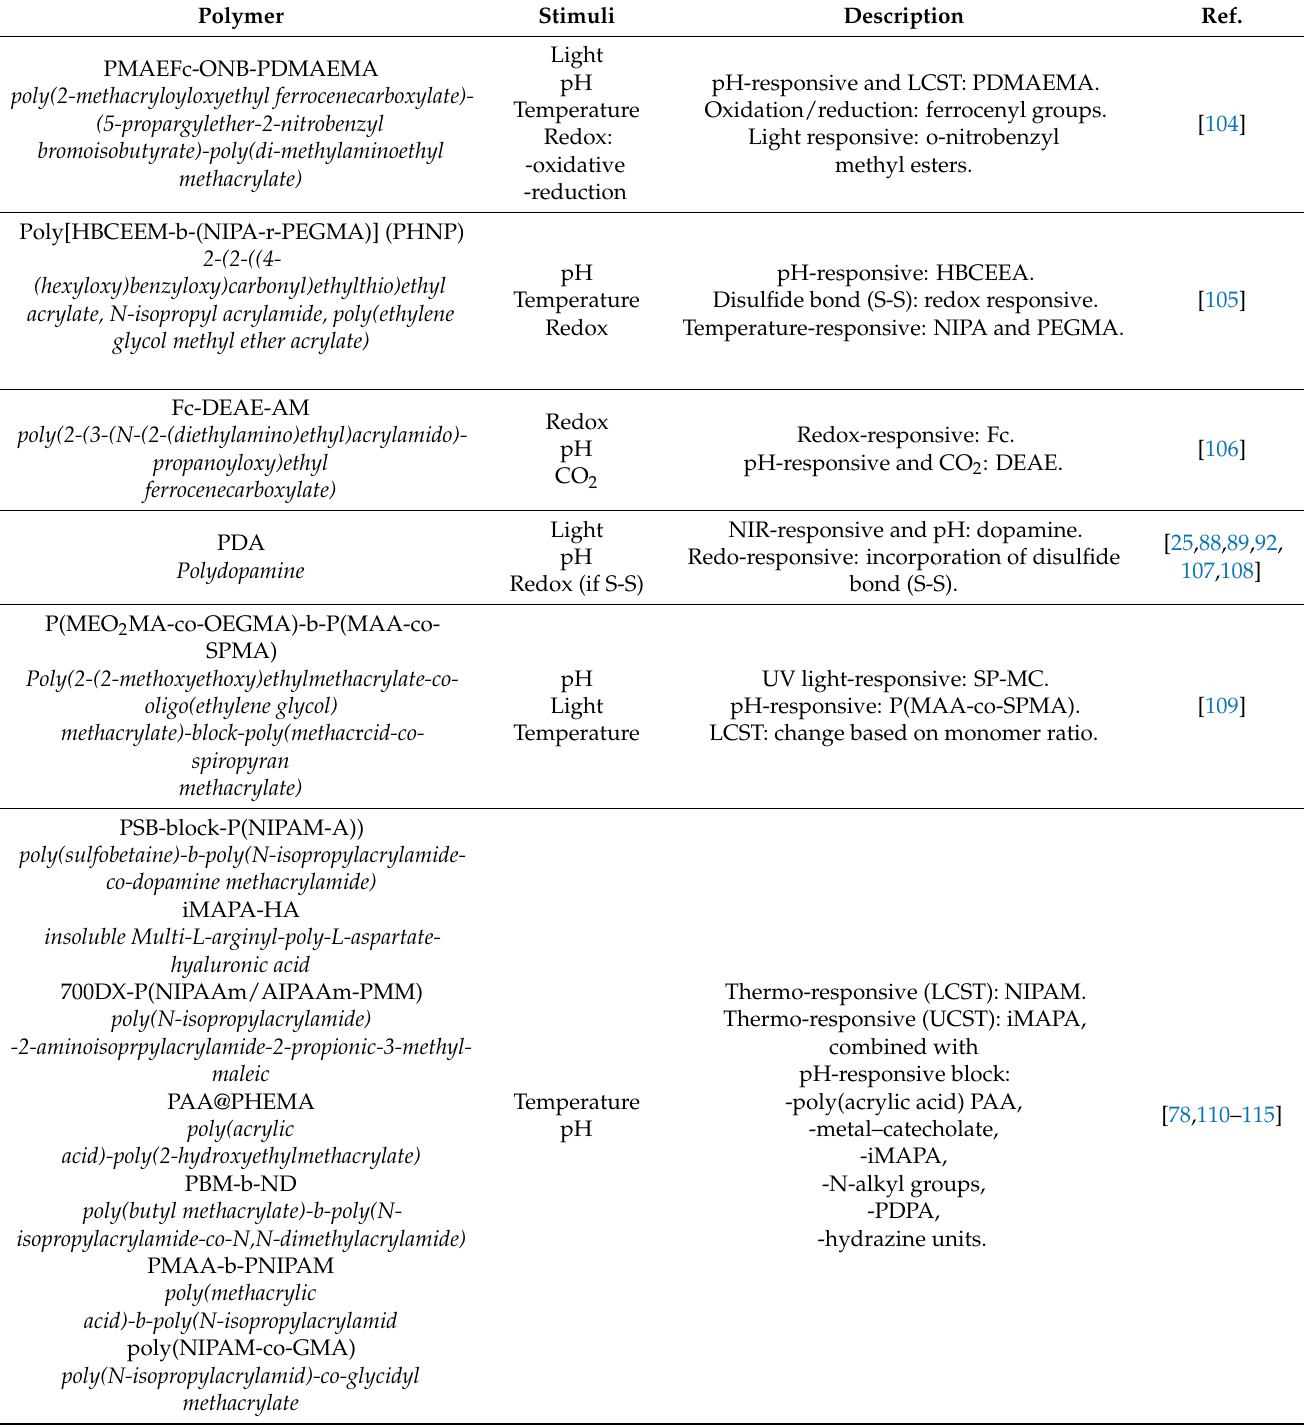
Table 4. A summary of recent multiple responsive polymers used for particle drug delivery systems